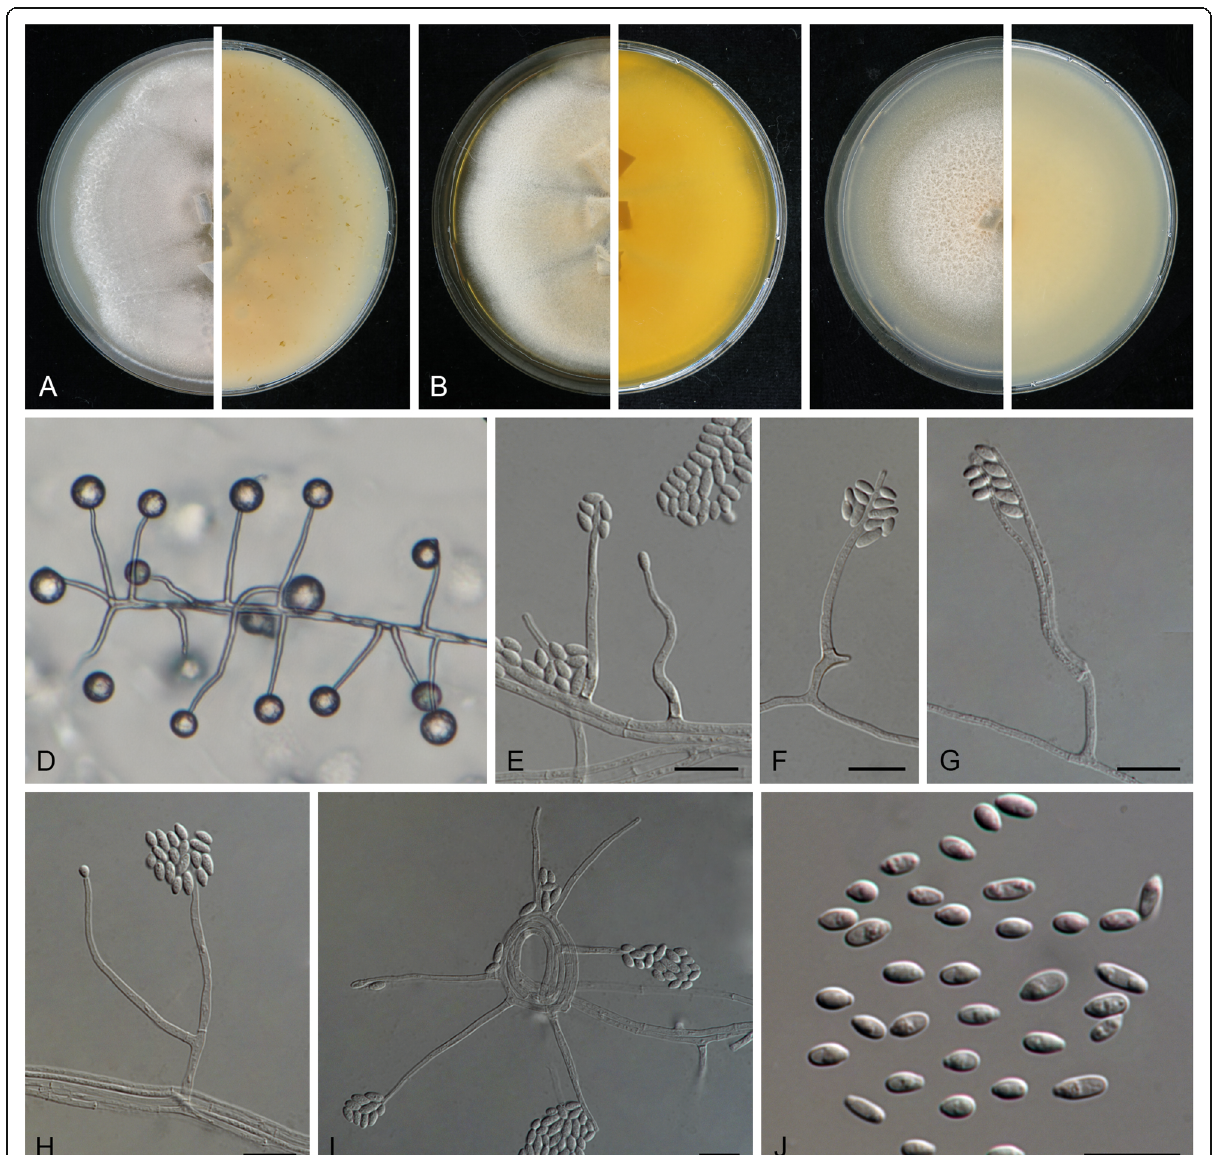
Fig. 7 Emericellopsis atlantica (ex-type CBS 147198). Colonies on OA ( a ), MEA ( b ) and PDA ( c ) after 21 d at 25 C. d – f, i Phialides. g – h . Branched conidiophores. j Conidia. Scale bars = 10 μ